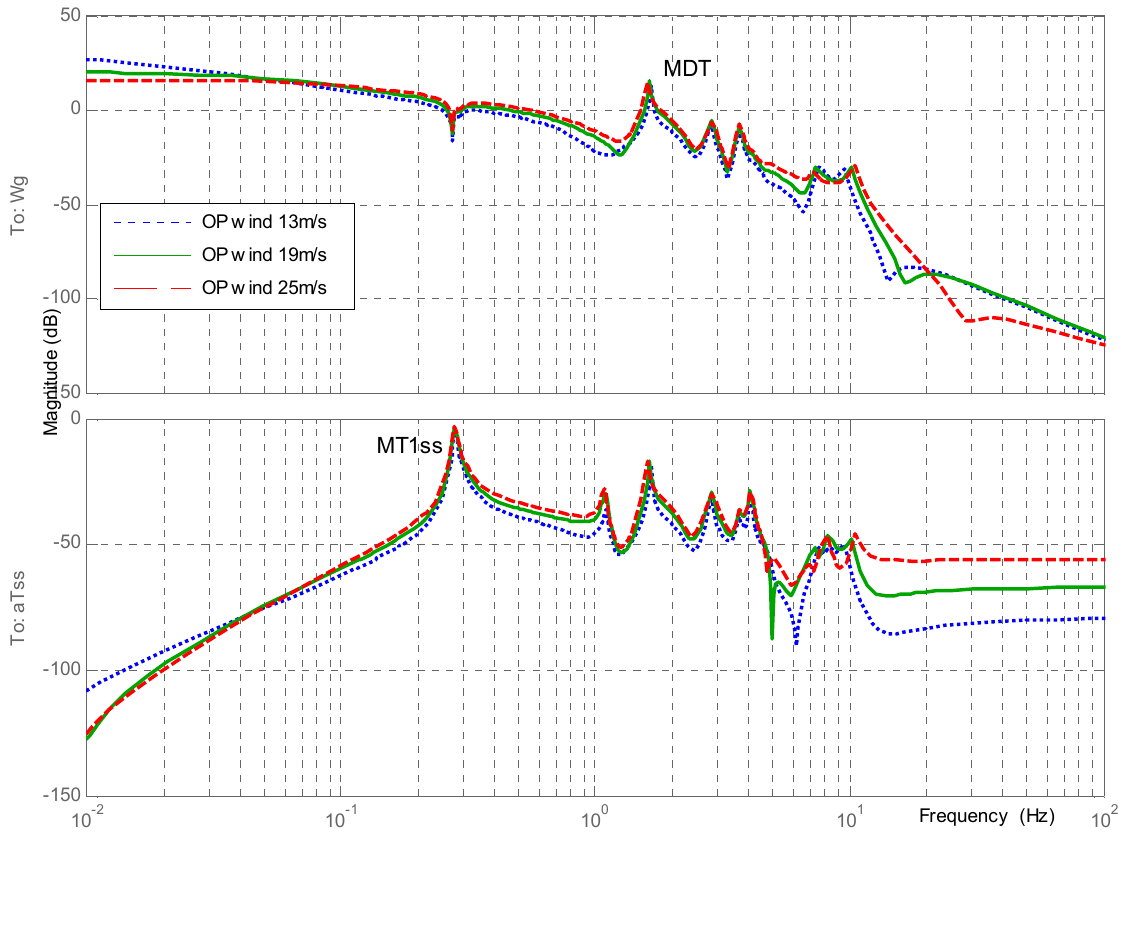
torque controller ∞